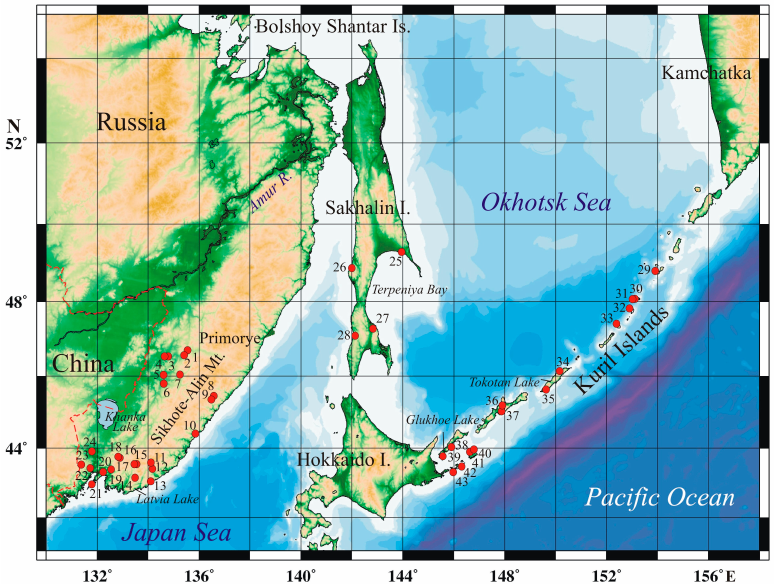
Figure 2. Study area and position of the sites recorded the late Holocene cold events. Continental area of South Far East: 1—Dillalakchi peat bog, Bikin River, 2—Krasny Yar peat bog, Bikin River, 3,